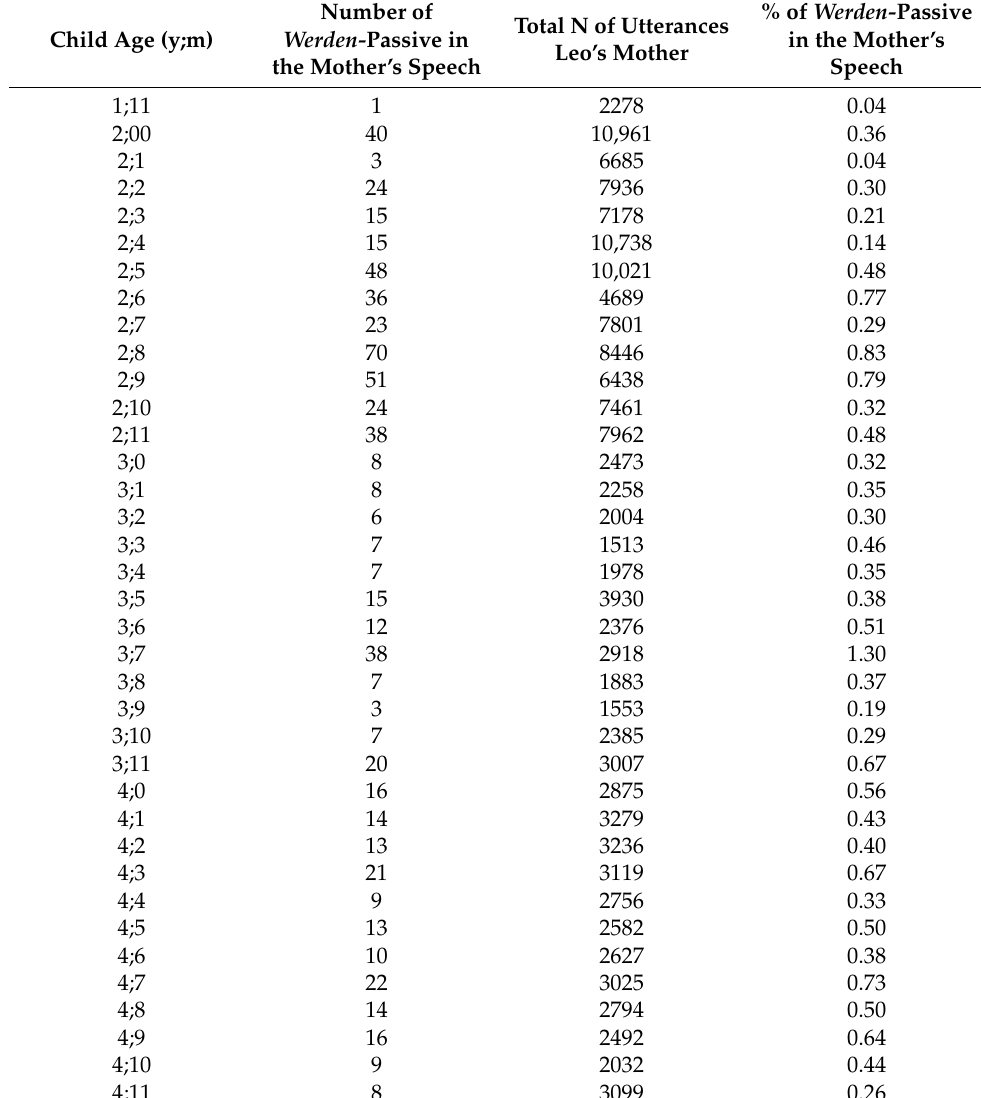
Table 10. Number of werden -passives (raw N, %) compared to the total number of utterances produced by Leo’s